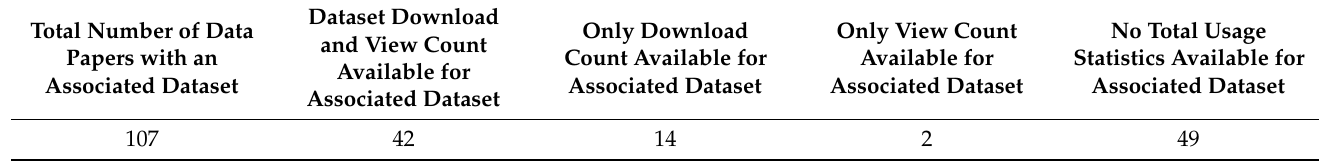
Table 2. Breakdown of the type of usage statistics available for each of the datasets associated with JOHD and RDJ data papers.